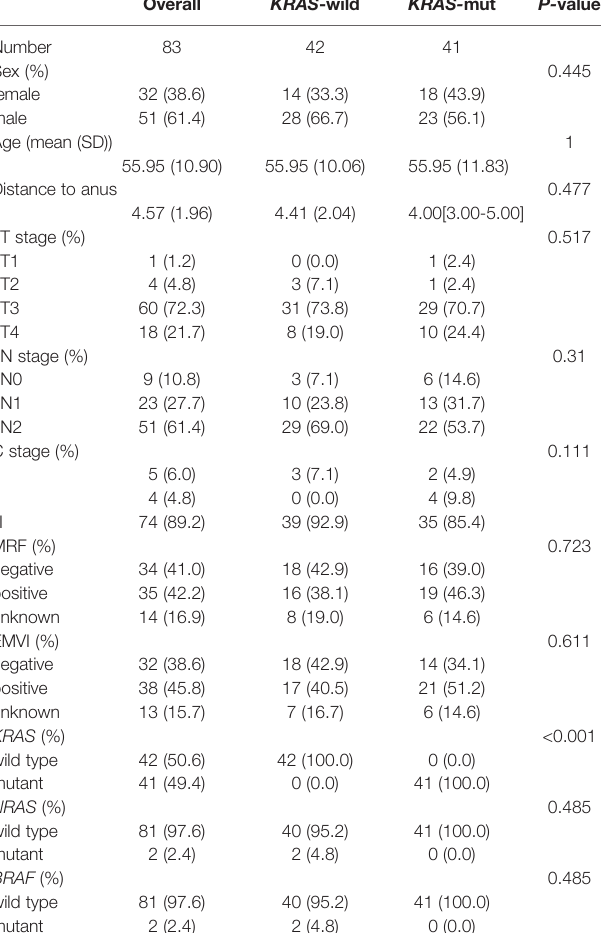
TABLE 1 | Demographic and clinical characteristics of the KRAS- mut and KRAS- wild populations. Overall KRAS